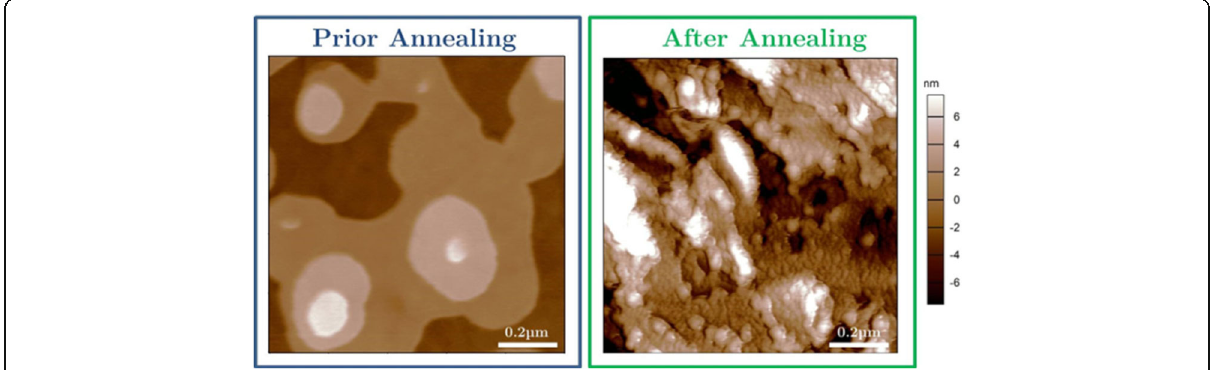
Fig. 7 AFM height images of evaporated DH4T acquired at room temperature before and after